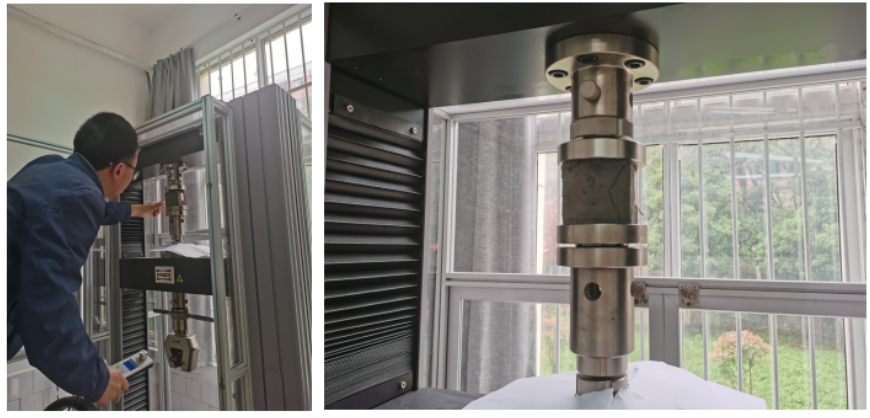
Figure 6. Test of similar